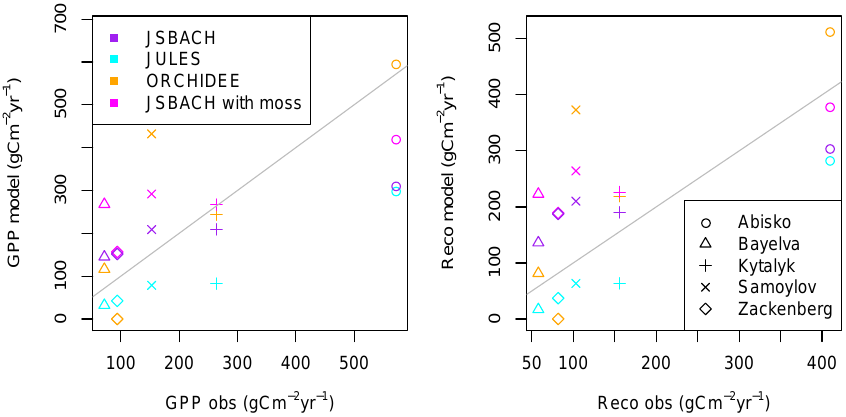
Figure 8. Mean annual GPP (gross primary productivity) and Reco (ecosystem respiration) from the models, plotted against the observation- derived values for the same time periods. See Table S1 for the years used at each site.